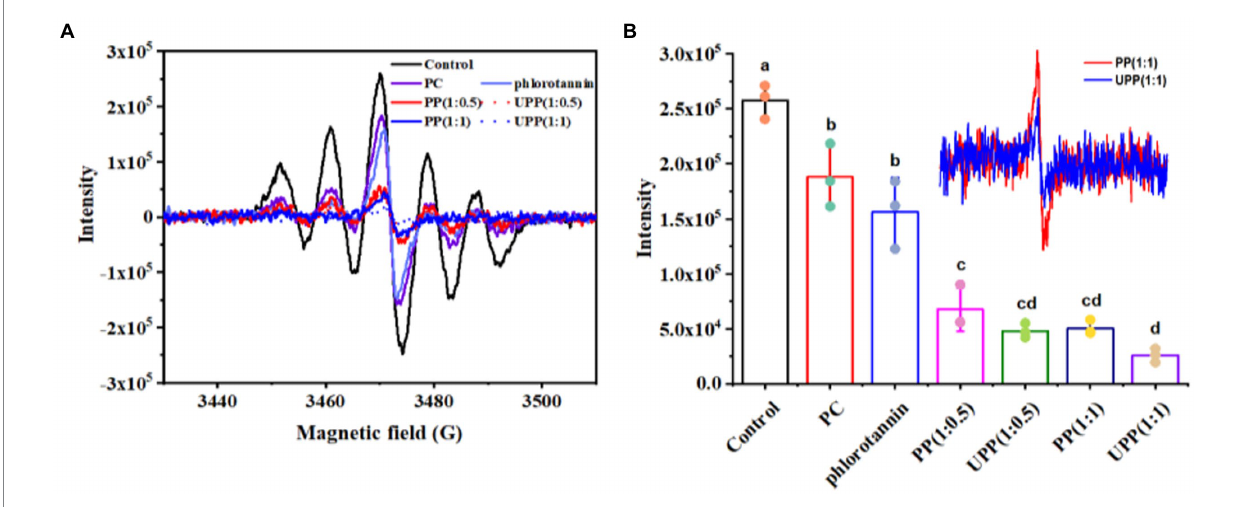
FIGURE 5 ESR spectra (A) , and maximum peak intensities (B) of PC, phlorotannin, PP and UPP on DPPH free radical scavenging ability. Different lowercase letters represent significant ( p < 0.05) differences between groups.